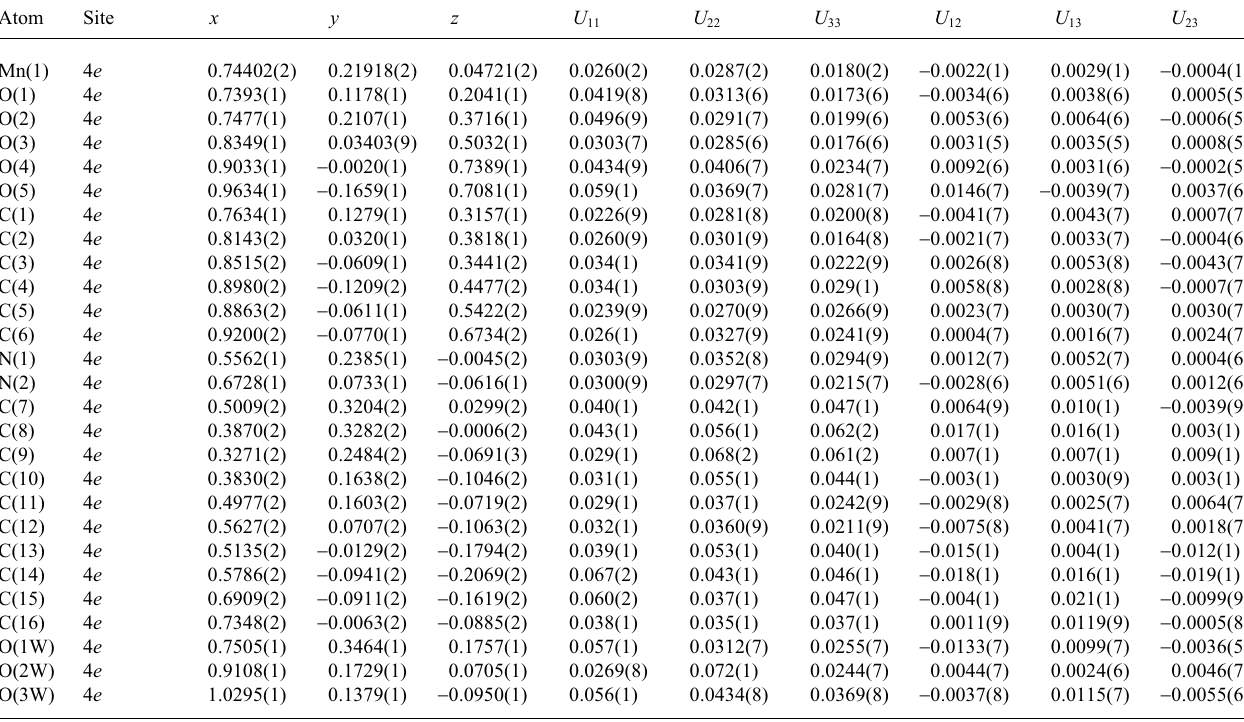
Table 3. Atomic coordinates and displacement parameters (in Å 2 )